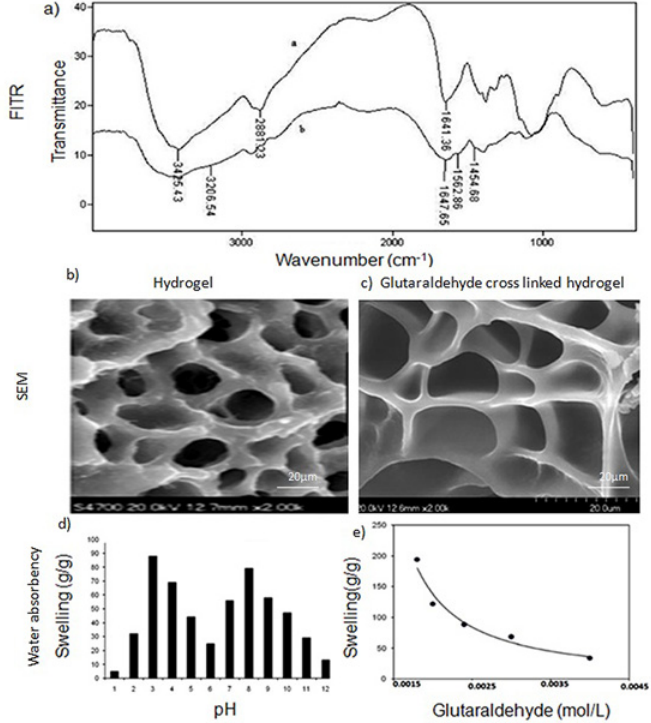
Fig 1. Physico-chemical properties of chitosan hydrogel. a) FTIR spectra of chitosan-based semi-IPN hydrogel. The broad band at 3425 cm -1 on the upper spectra corresponds to the associated-OH stretching vibrations of the hydroxyl groups. The peak at 1641 cm -1 corresponds to N-H deformation bending of chitosan. In the lower spectrum of the hydrogel, new peaks appeared at 3206, 1647, and 1562 cm -1 and these may be due to amide NH stretching, asymmetric, and symmetric amide NH bending, respectively. b&c) SEM images of the hydrogel and the glutaraldehyde cross linked chitosan-based hydrogel, respectively. Pore size of 110 μ m and loose architecture was observed for the latter. d) Effect of pH and cross linker concentration on water absorbency of the semi-IPN. The two sharp swelling capacity changes can